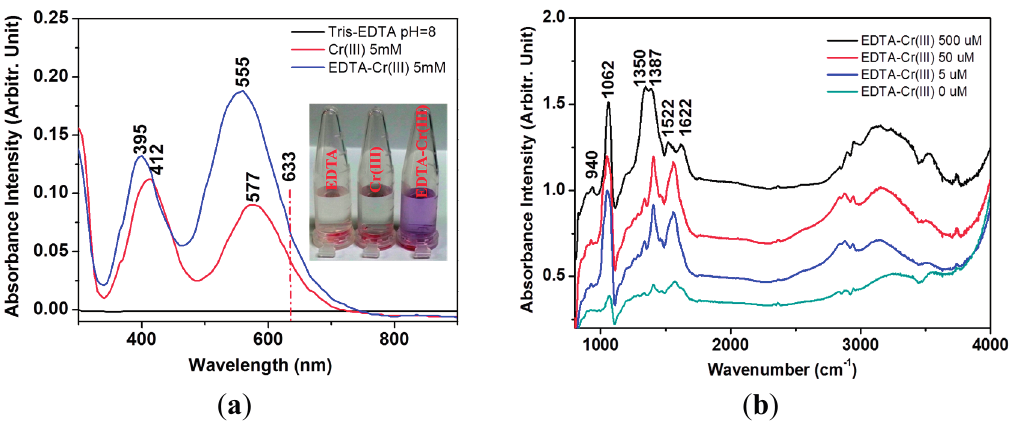
Figure 1. ( a ) UV-Vis spectra of ethylenediaminetetraacetic acid (EDTA), Cr(III), and EDTA-Cr(III). The inset shows the photo images. The dotted line indicates 633 nm; ( b ) Fourier transform infrared (FT-IR) spectra of EDTA-Cr(III) at 800–4000 cm − 1 .